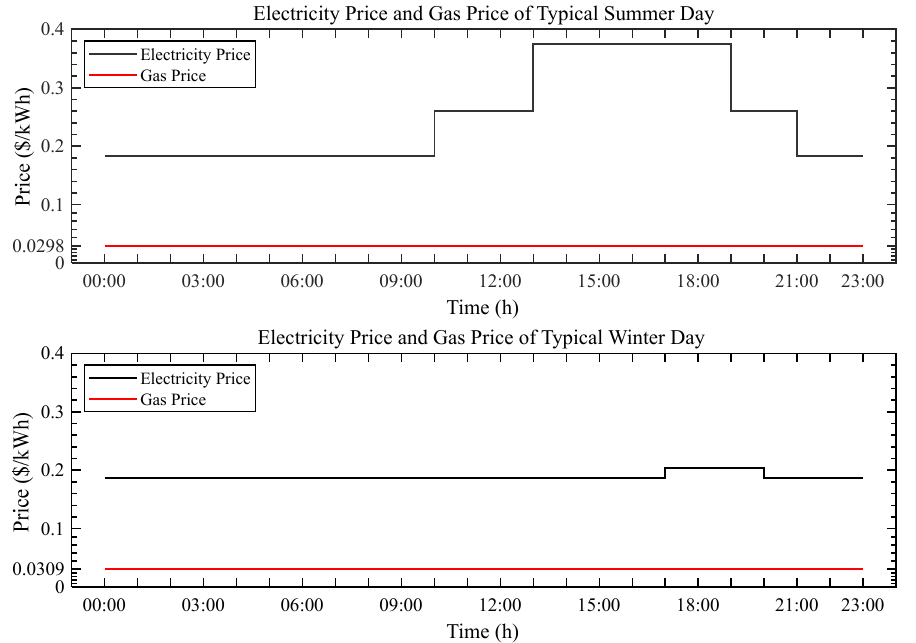
Figure A3. Electricity purchase price and natural gas price for the summer and winter days.